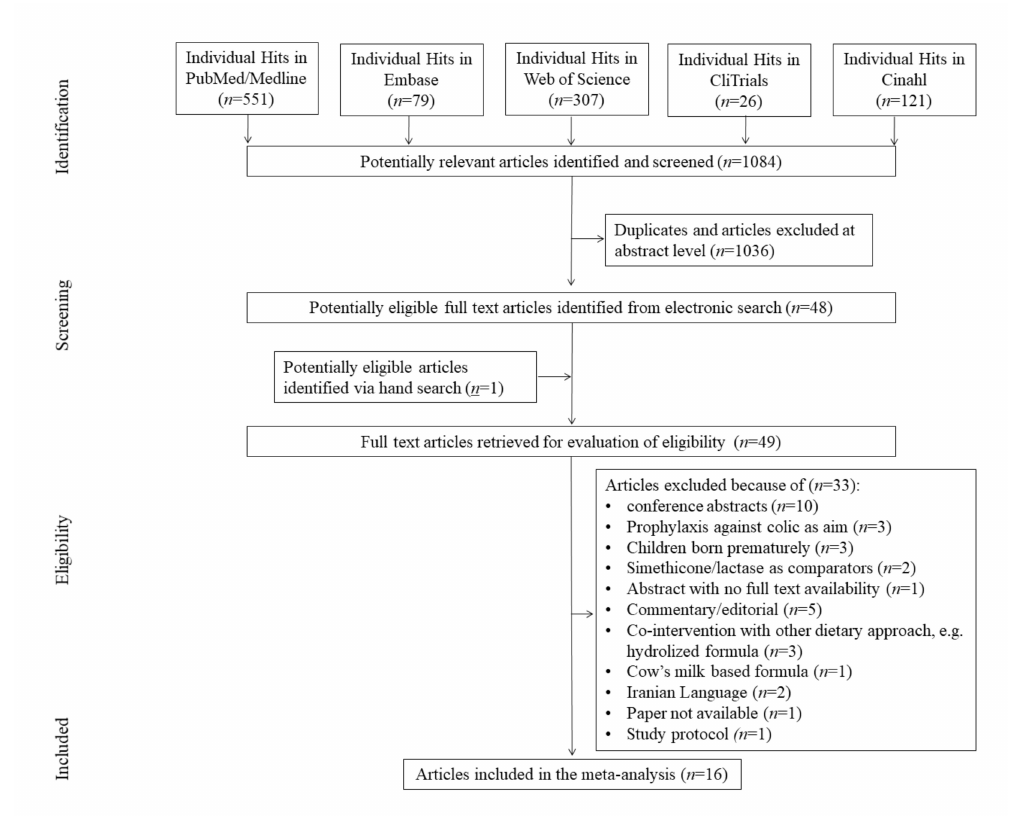
Figure 1. PRISMA flow